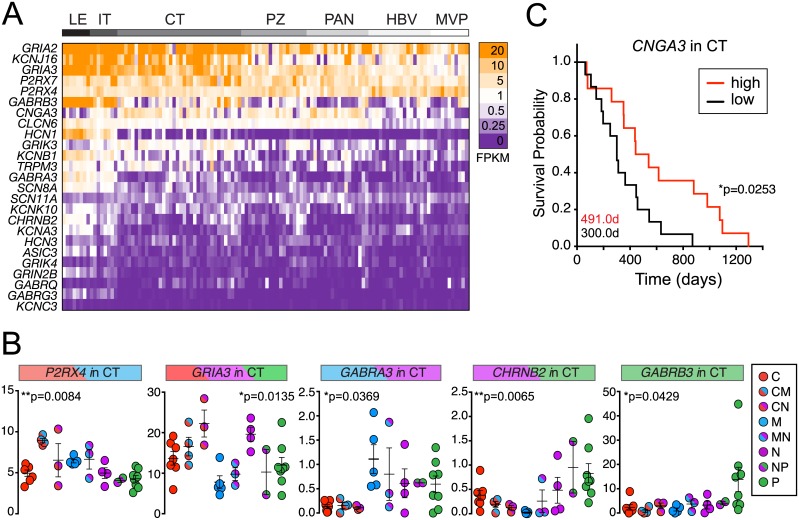
IGCs are enriched in distinct GBM tumor regions.A. Heat map of expression levels of the top 25 IGCs in various GBM tumor regions from the Ivy GAP RNA-seq database. B. IGCs associated with particular molecular subtypes in CT samples. Colored headers indicate predominant subtype associated with that ion channel. Bars, mean ± SEM. Kruskal-Wallis test across molecular subtypes. C. Survival curve for CNGA3 within CT samples stratified high/low by median FPKM value (3.908). Log-rank (Mantel-Cox) test. Median days to death for each group reported on graph. Leading Edge (LE), Infiltrating Tumor (IT), Cellular Tumor (CT), Perinecrotic zone (PZ), Pseudopalisading cells around necrosis (PAN), Hyperplastic blood vessels in cellular tumor (HBV), Microvascular Proliferation (MVP).